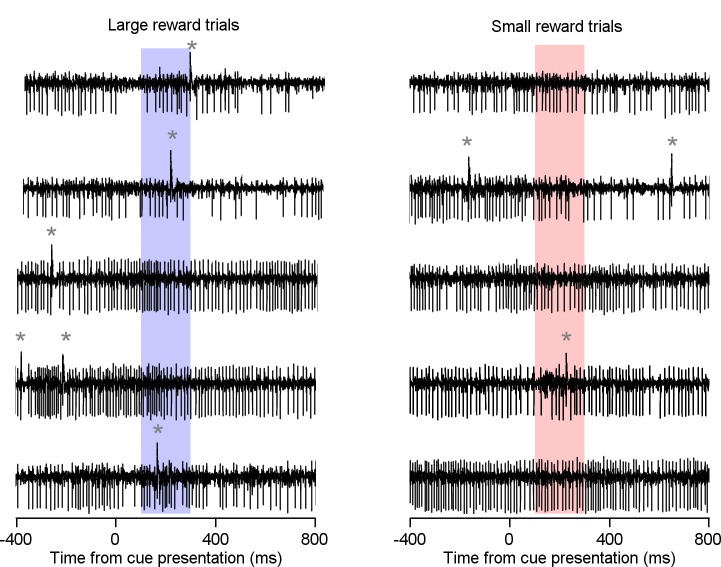
Fraction of trials with Cspks following the cue presentation is higher in the large reward condition than in the small reward condition.Examples of raw data traces of individual trials for the example cell in Figure 2A in the large (right) and small (left) reward conditions. The gray asterisks mark a Cspk and the colored rectangle marks the 100–300 ms time bin following the cue. Trials with more than a single spike in the analysis window were very rare.